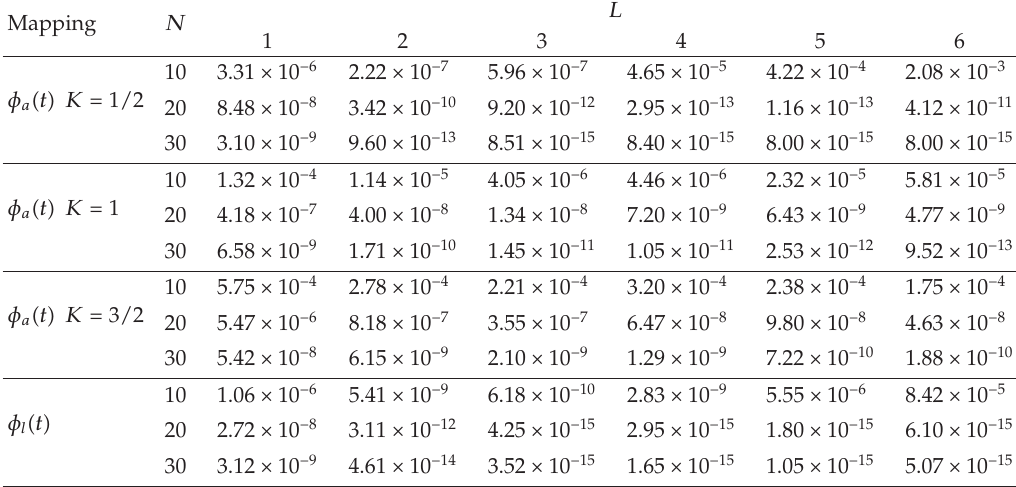
Table 1: Maximum absolute errors for Example